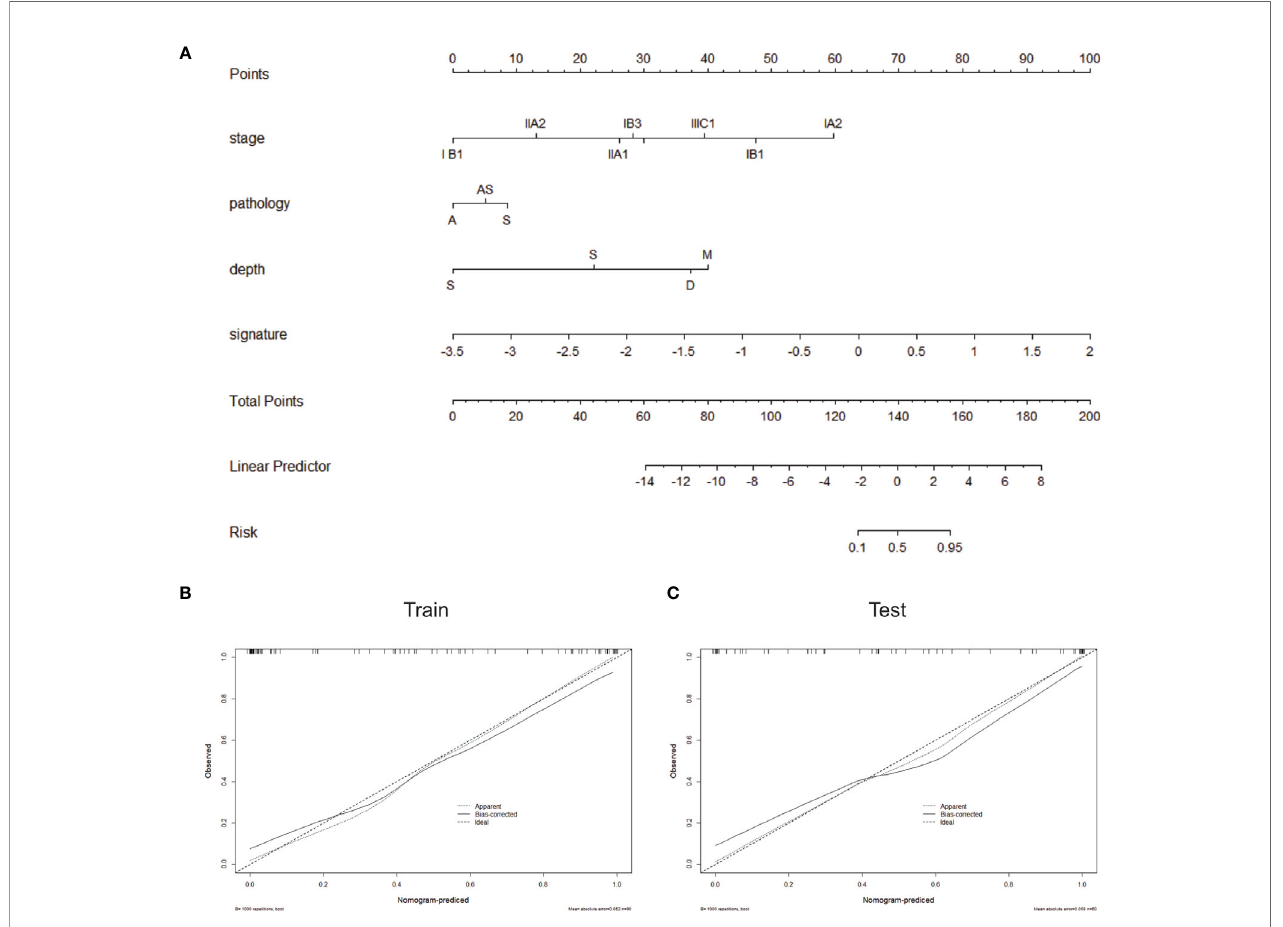
FIGURE 6 | (A) The radiomics-based nomogram. Calibration curves in the training cohort (B) and validation cohort (C) . Closer fi t to the diagonal line indicates a better